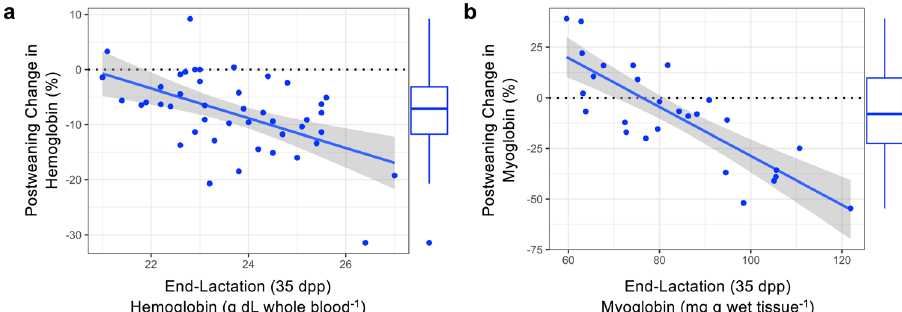
Fig. 4 Hemoprotein concentration at the end of lactation determined the magnitude of hemoprotein loss post-weaning. Female Weddell seals with higher ( a ) blood hemoglobin and ( b ) muscle myoglobin at the end of lactation (35 dpp) exhibited greater declines in hemoprotein concentrations post- weaning (by 95 dpp) on a percent basis (See Supplemental material for changes in absolute values). Gray bands depict the 95% con fi dence interval around the regression model line (center of error bands); boxplots depict the distribution of changes in hemoprotein concentrations where boxes encompass the interquartile range, the center line denotes the median, whiskers encompass range of values, and points above or below the whiskers are greater/less than